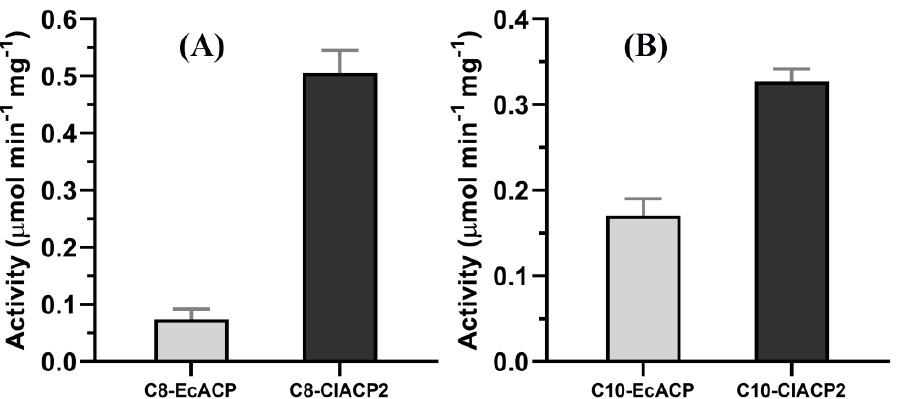
Figure 2. Relative activity of ChFatB2 with acyl-ACPs. ( A ) Relative activity of ChFatB2 with C8-EcACP and C8-ClACP2 as the substrate. ( B ) Relative activity of ChFatB2 with C10-EcACP and C10-ClACP2 as the substrate.